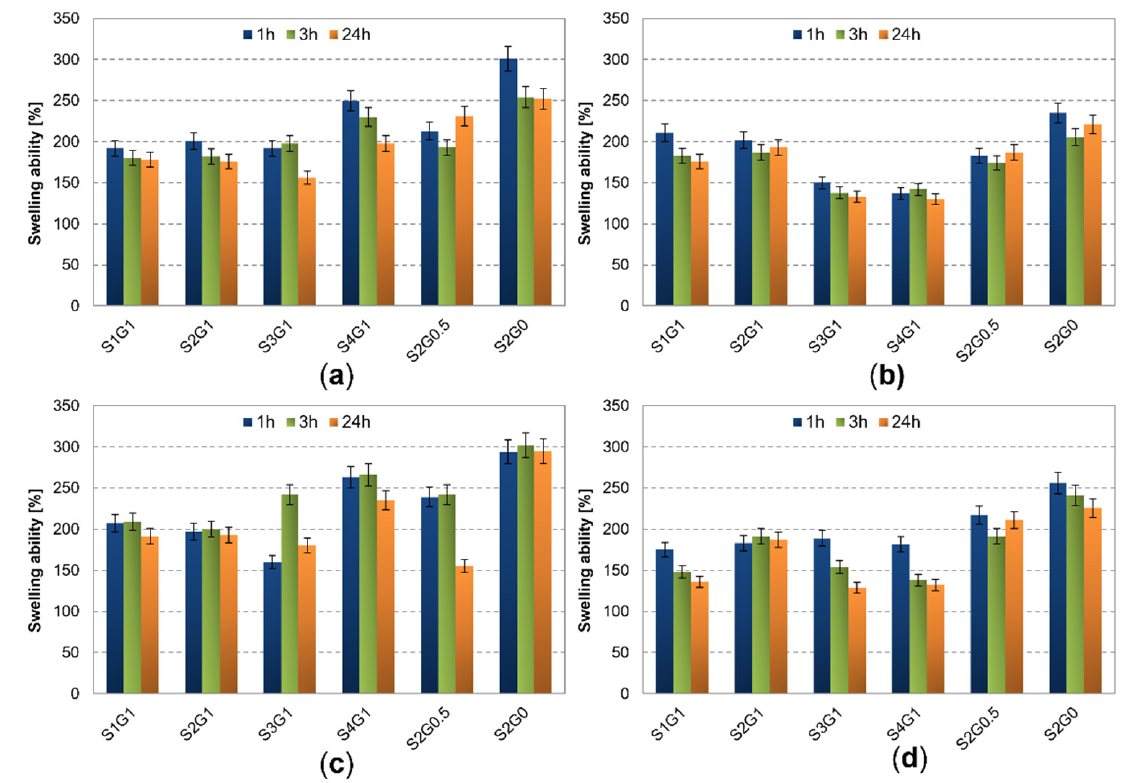
Figure 1. Effect of hydrogel composition on swelling degree after immersing in ( a ) distilled water at ambient temperature; ( b ) distilled water at 37 °C; ( c ) PBS at ambient temperature; ( d ) PBS at 37 °C ( n = 3).